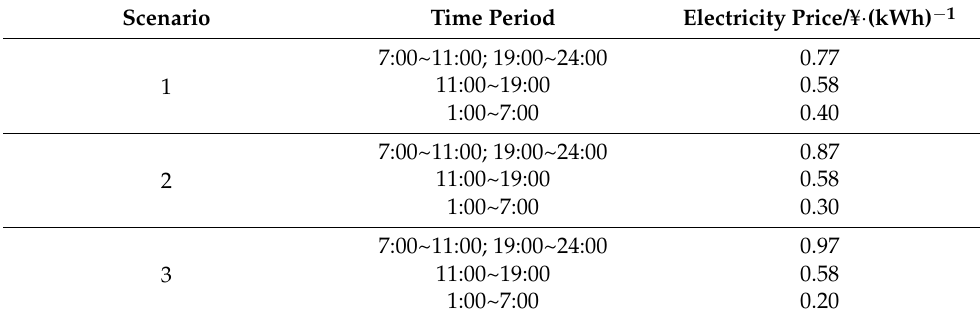
Table 5. Time-of-use rate.